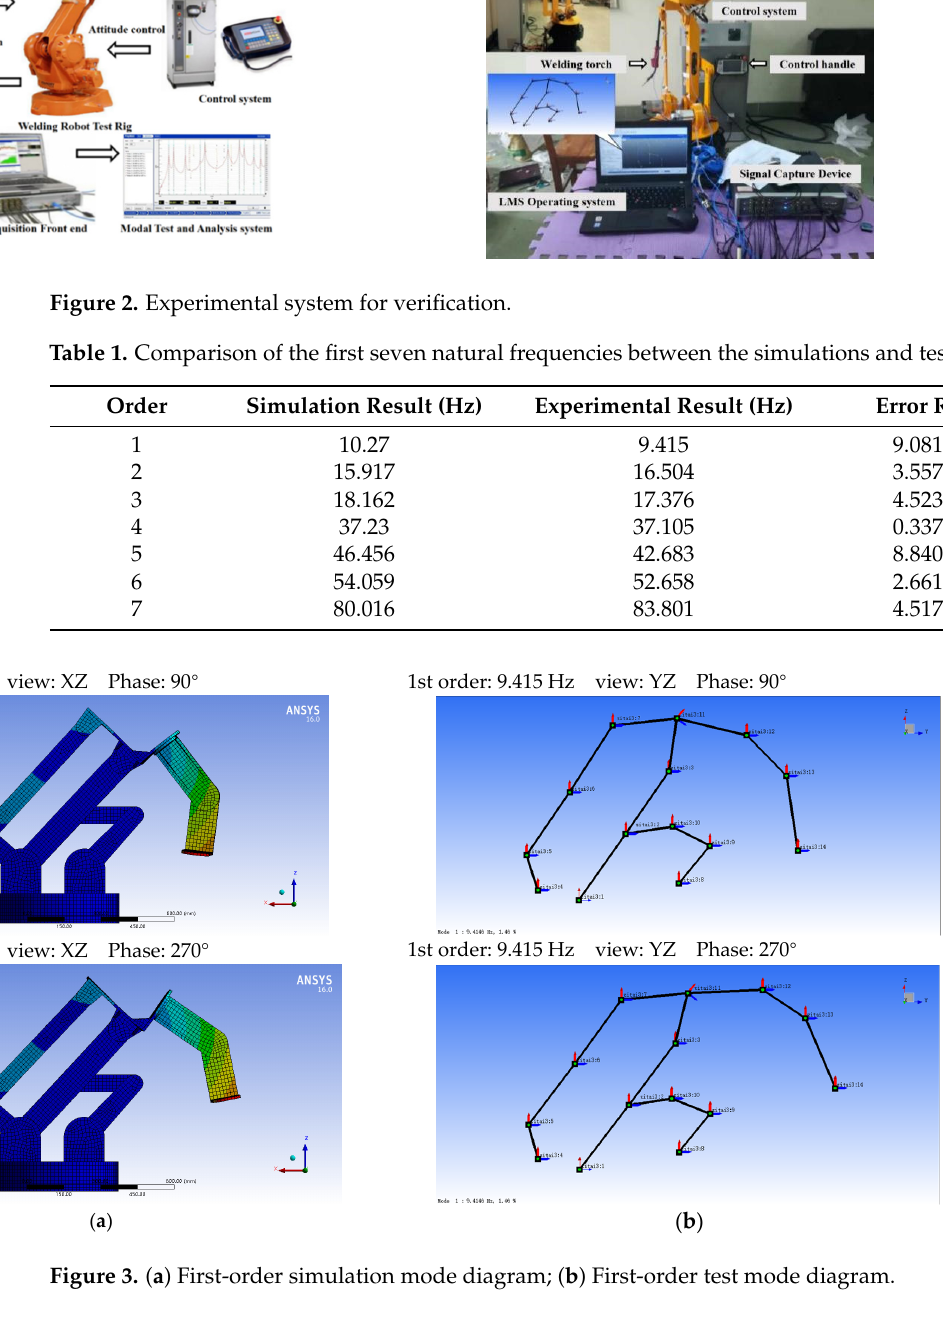
Figure 3. ( a ) First-order simulation mode diagram; ( b ) First-order test mode diagram.